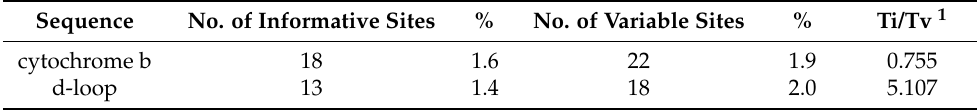
Table 6. Number of sites and Ti/Tv ratio for cytochrome b and d-loop mitochondrial markers specific to the Grey Steppe population.